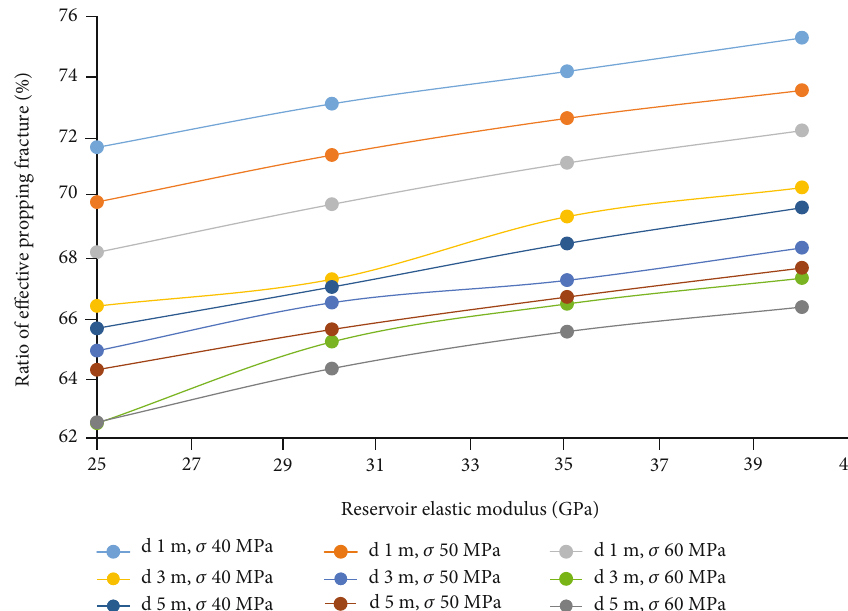
Figure 39: The in fl uence of reservoir elastic modulus at 3 mm height and di ff erent diameters on the ratio of e ff ective supporting fractures.